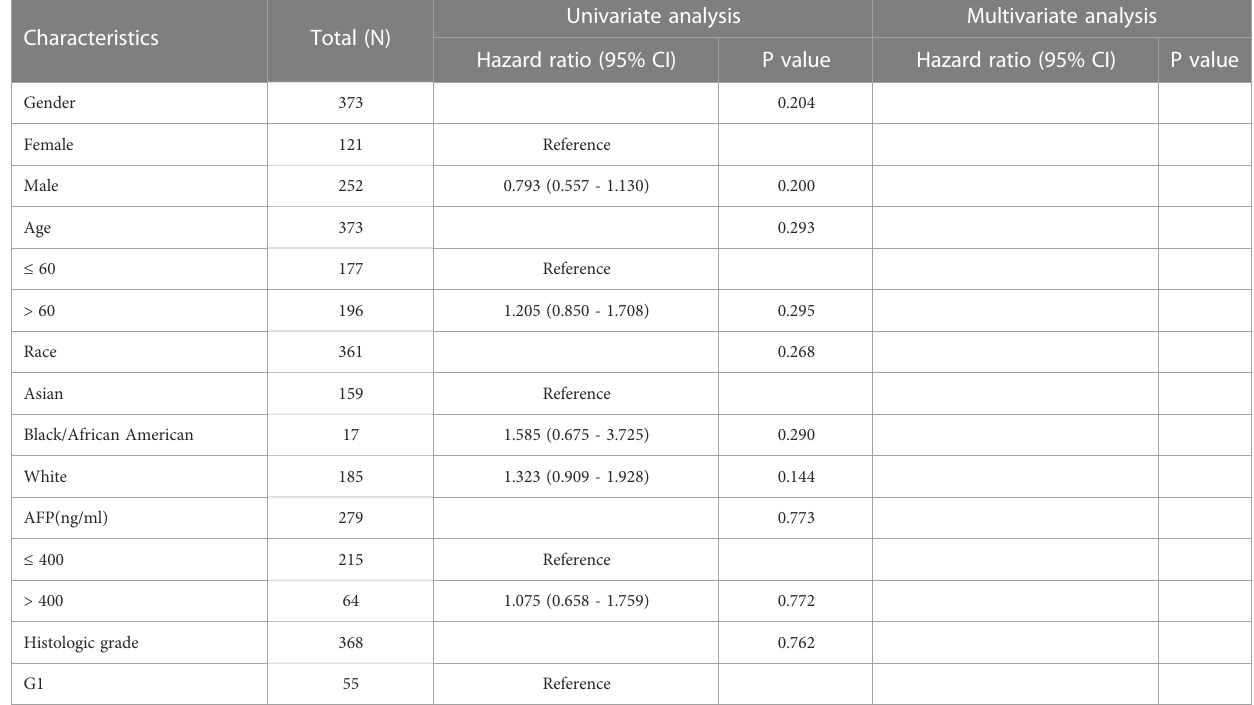
TABLE 3 Overall survival